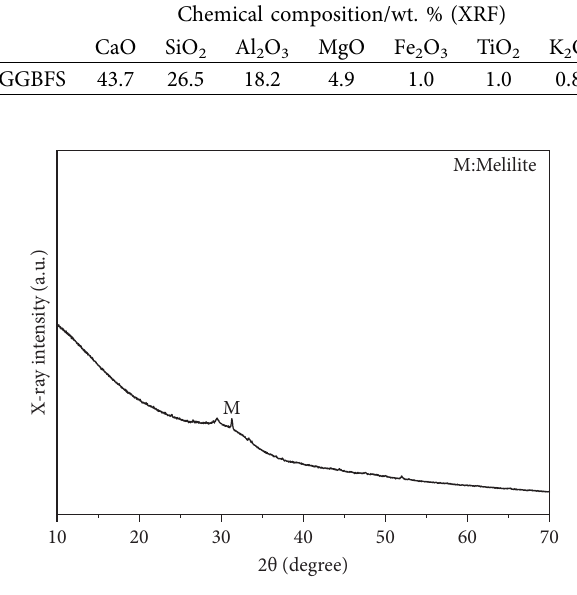
Figure 1: XRD pattern of